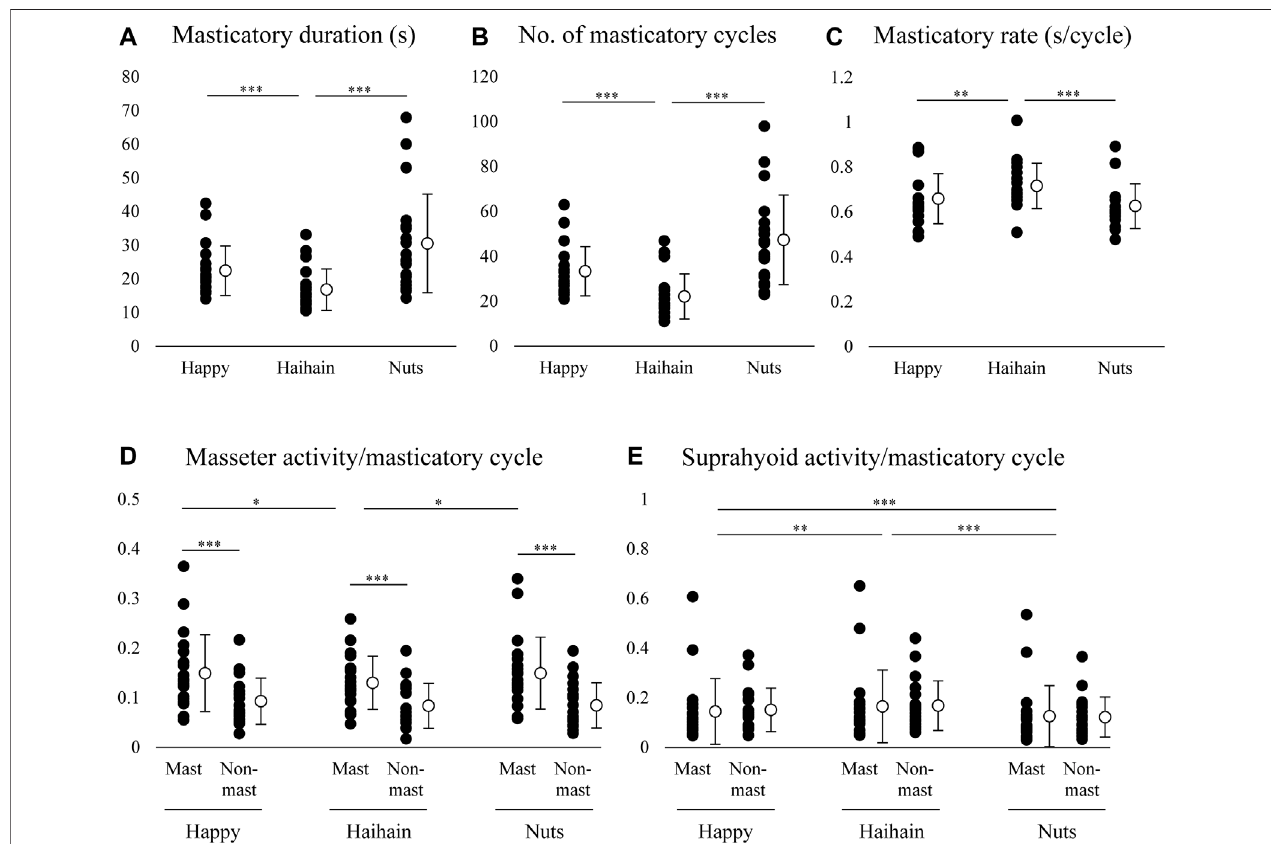
FIGURE 6 | Masticatory duration, number of masticatory cycles, masticatory rate, masseter and suprahyoid electromyographic activity per masticatory cycle. Open circles indicate mean values. (A) Masticatory duration was signi fi cantly different between Happy and Haihain mastication and between Haihain and Nuts mastication. (B) Signi fi cant difference in the number of masticatory cycles between Happy and Haihain mastication and between Haihain and Nuts mastication. (C) Signi fi cantdifference inthemasticatory rate between Happyand Haihain masticationand betweenHaihainand Nuts mastication. (D) Signi fi cantlyhigher masseter activity on the masticatory side (Mast) than that on the non-masticatory side (Non-mast). There was also a signi fi cant difference on the masticatory side between Happy andHaihainandbetweenHaihainandNuts. (E) DifferenceinsuprahyoidactivitynotedbetweenHappyandHaihain,betweenHappyandNuts,andbetweenHaihainand Nuts. There was no difference between the sides. *** p < 0.001, ** p < 0.01, * p < 0.05.